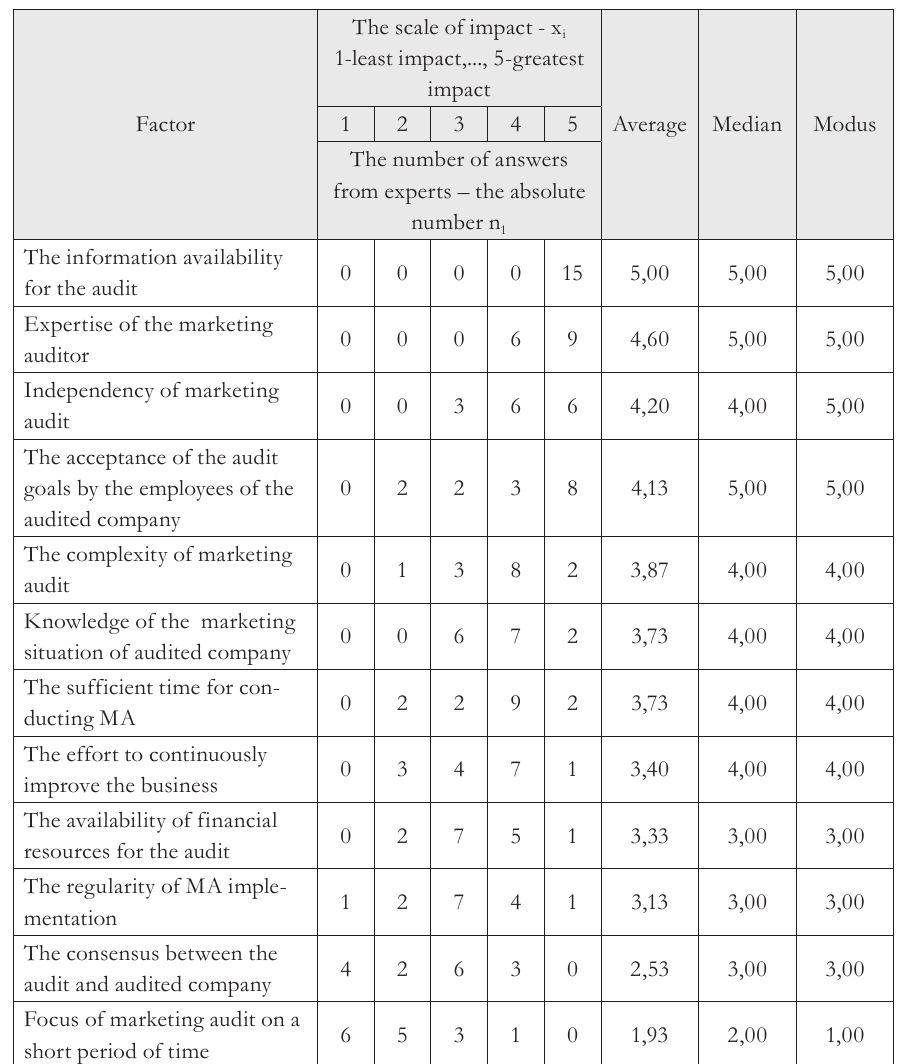
Tab. 1 – The significance of the impact of the analyzed factors on the effectiveness and results of marketing audit (from an expert point of view). Source: Own